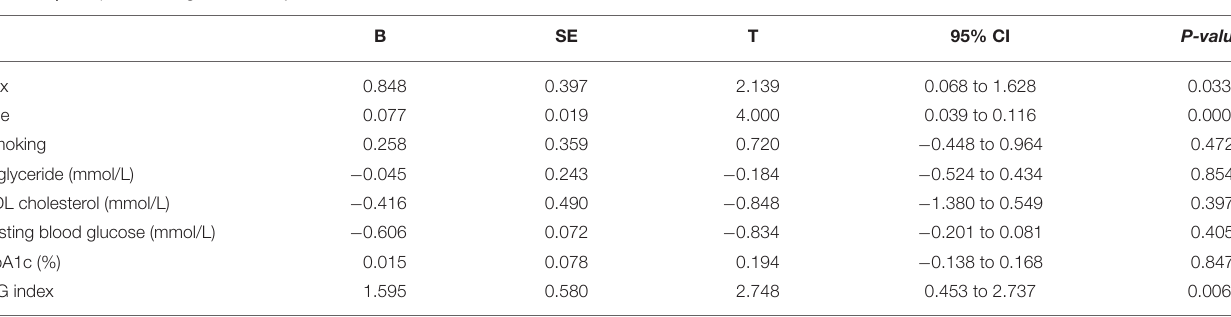
TABLE 4 | Multiple linear regression